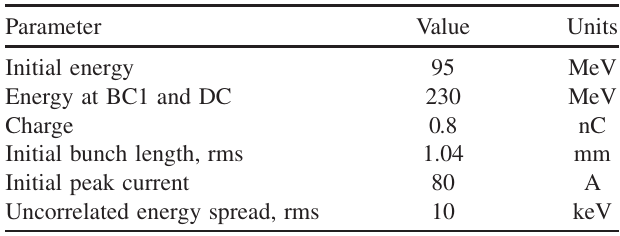
TABLE I. Electron beam